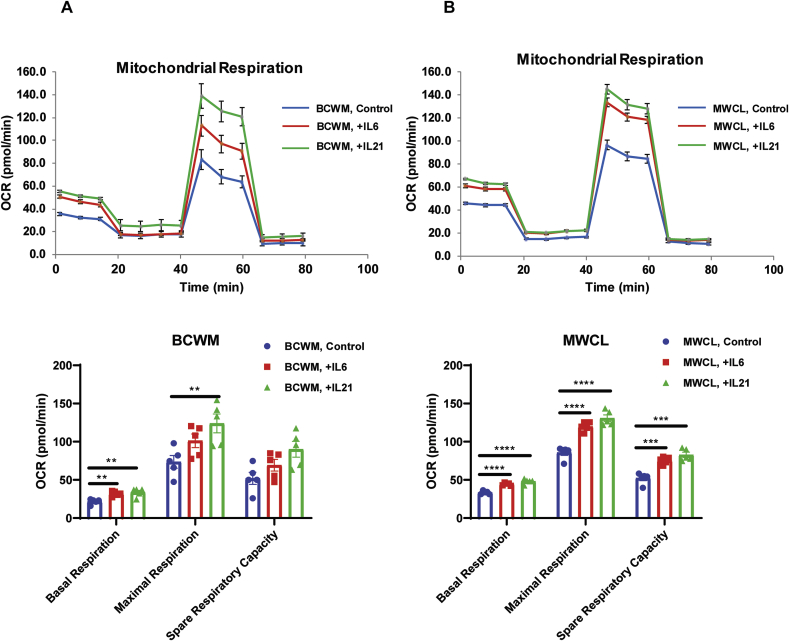
Cytokines IL-6 and IL-21 increase oxygen consumption rate in WM. Mitochondrial stress test analysis shows the effect of IL-6 or IL-21 on the oxygen consumption rate (OCR) in both BCWM.1 (A) and MWCL-1 (B) cell lines using Agilent XFe96 seahorse analyzer. Data is the mean ± SE of five replicates (n = 5). Bar graphs compare the basal respiration, maximal respiration and spare respiratory capacity between untreated and treated groups. Significant differences are shown as **p < 0.01, ***p < 0.001, ****p < 0.0001 on the bar graphs.